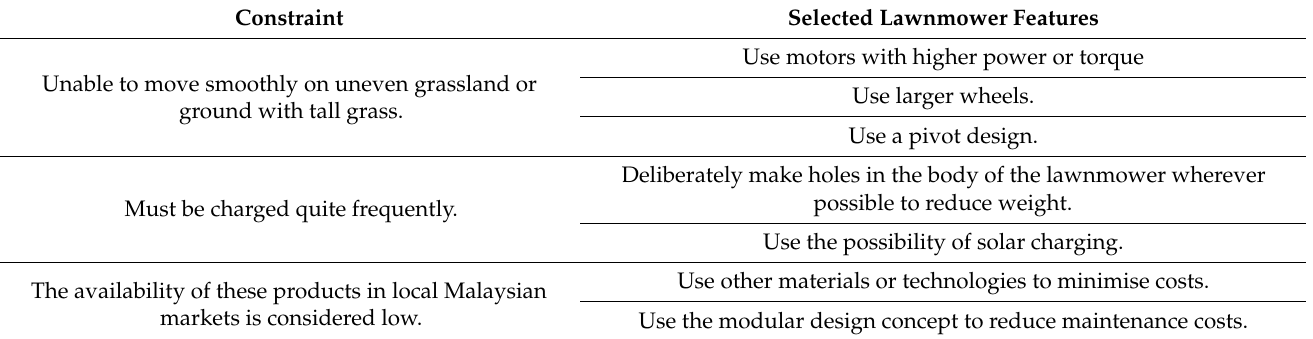
Table 16. List of the selected proposed